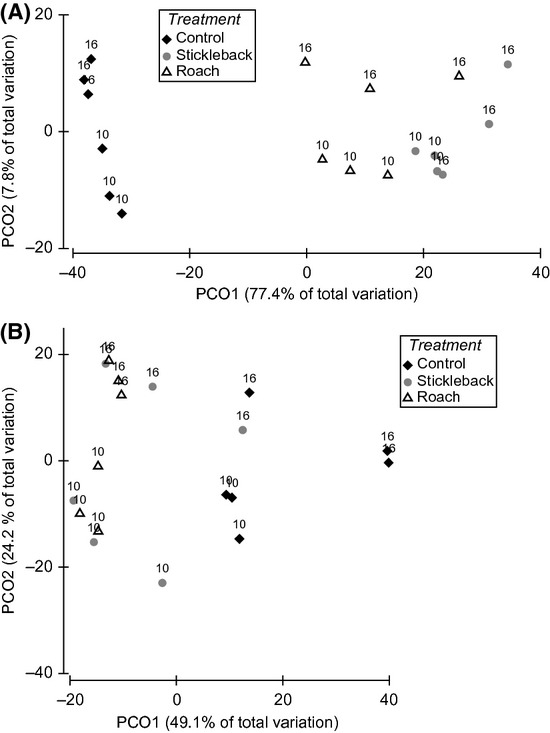
Principal coordinates ordination (PCO) of distances among samples on the basis of square-root-transformed Bray–Curtis measures of taxa abundance at the last two sampling dates (days 10 and 16) in (A) spring and (B) summer experiments.